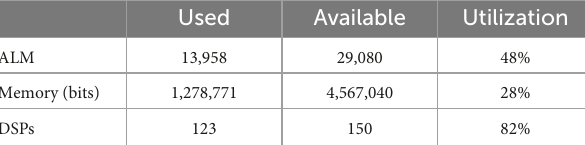
TABLE 1 Device utilization summary.